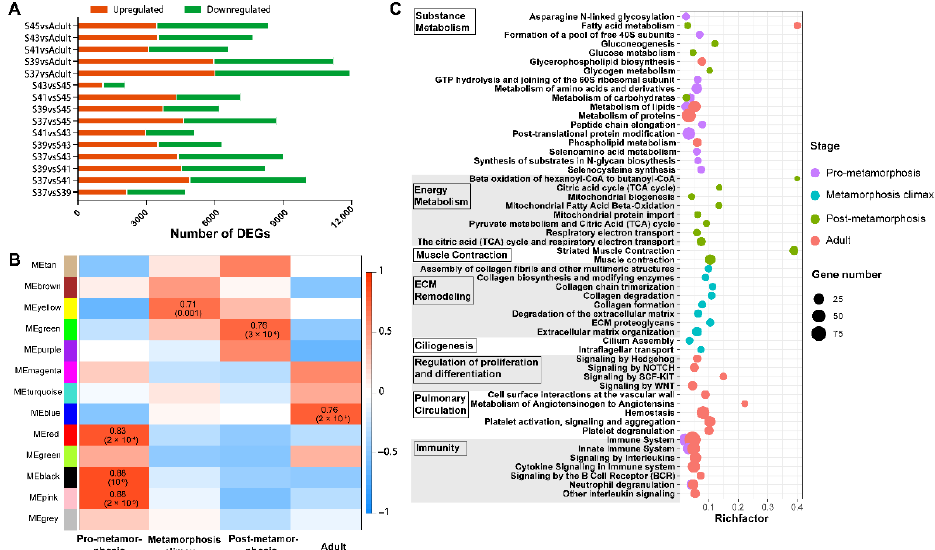
Figure 2. WGCNA and functional enrichment of gene modules. ( A ) The DEGs identified in all pairwise comparisons of stages; ( B ) The correlations between module eigengenes and developmental phases. The color scale indicates the strength of correlation; ( C ) The main functional items of enriched gene modules (FDR < 0.05) in different developmental stages ( n = 3 each stage). Furthermore, we explored the variation patterns of featured genes at different developmental phases. In the pro-metamorphic phase, we identified 23, 15, 17, and 25 featured genes involved in protein turnover (i.e., ribosomal component and proteolysis- related genes), lipid metabolism, amino acid metabolism, and carbohydrate metabolism,